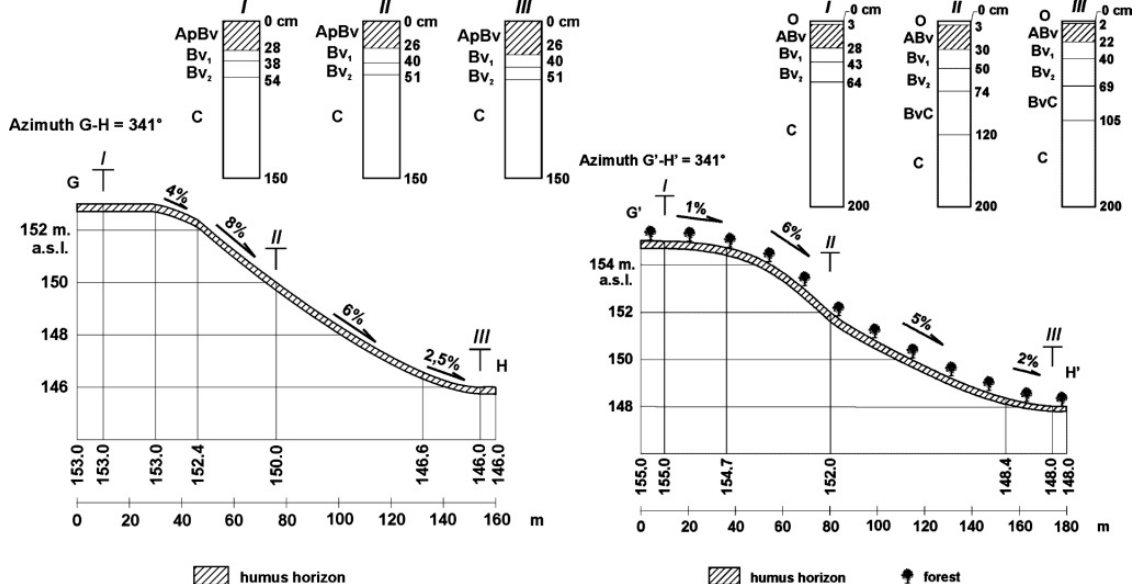
Figure 4. The soil cross sections G-H and G’-H’. Slope gradient in %; A: humus horizon; B: enrichment horizon; C: parent material (substratum); O: organic horizon; p : plow layer; v: occurrence of plinthite [39].